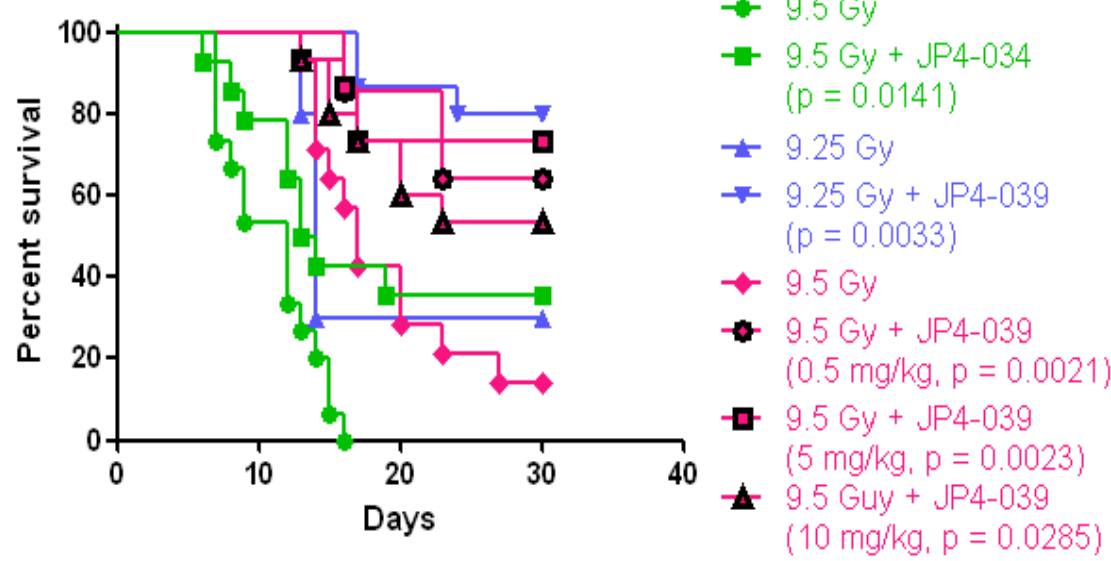
Figure 3. Effective mitigation of total body irradiation damage in C57BL/6NHsd mice by intravenous administration of JP4-039. Experiments shown are over a course of a year accounting for the TBI dose “drift” of the LD 50/30 . At 3 different time points during a single calendar year, experiments were carried out delivering JP4-039/F15 in 100 μL volume containing 20 mg/kg drug, to mice. In these experiments, the LD 50/30 was noted to “drift” over the course of the year and could not be explained by changes in the Cesium-70 Gamma Cell irradiator, supplier of mice, age of mice, gender of mice (all were female), diet, or other factors in the animal care facility. In all experiments, despite the “drift” of the LD 50/30 , JP4-039 was an effective mitigator against total body irradiation.